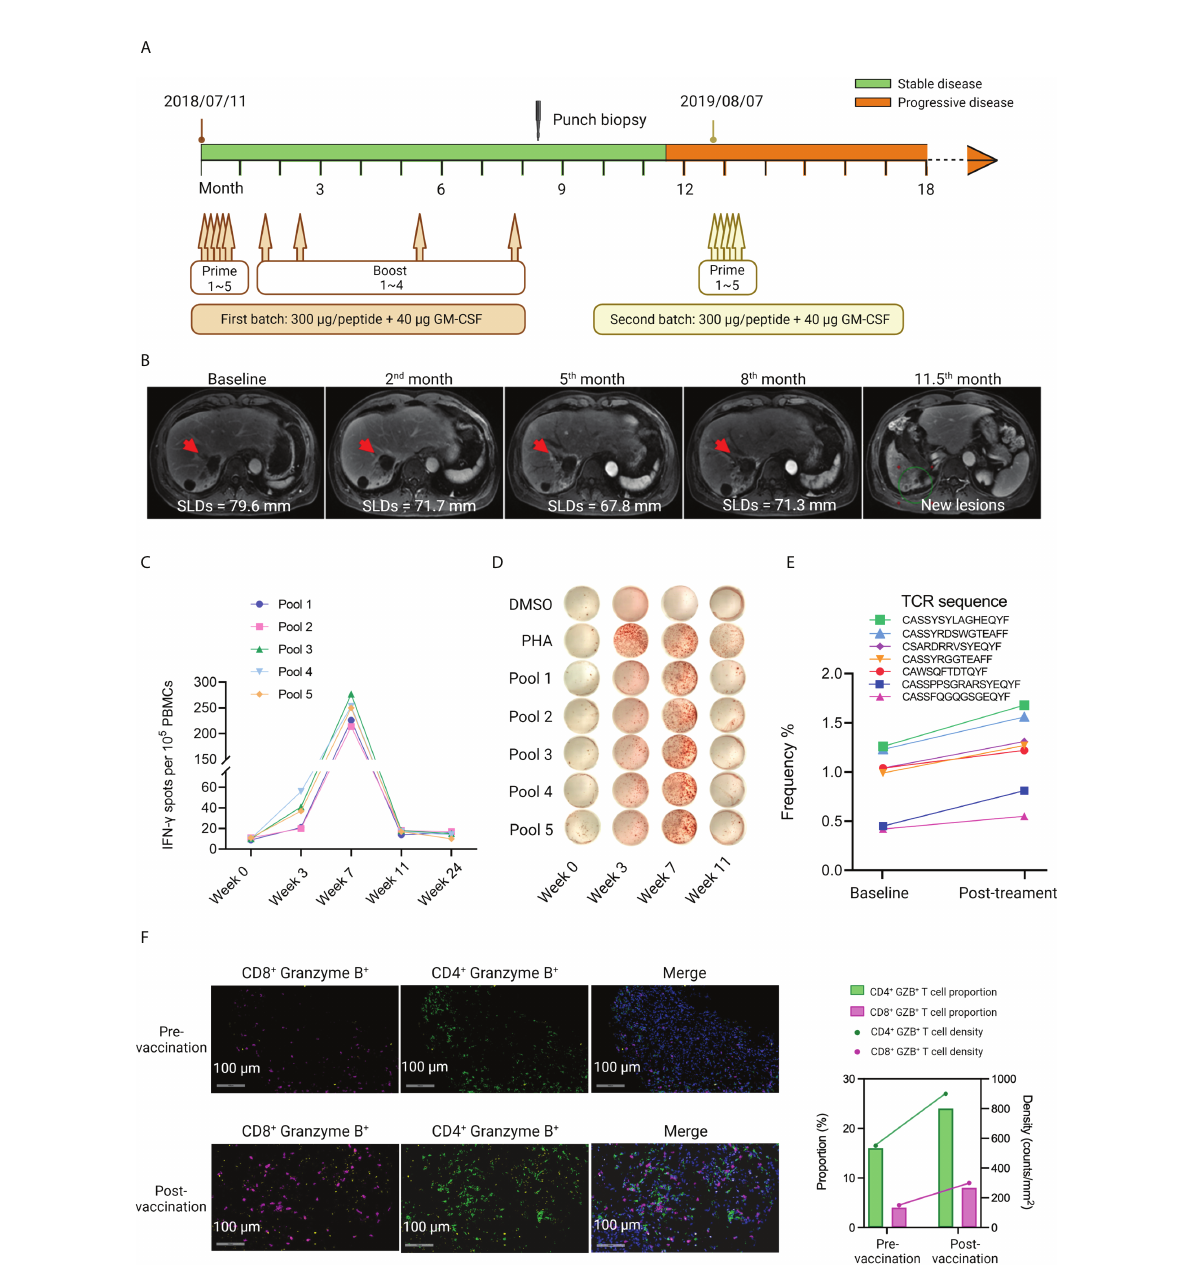
FIGURE 4 Case report of patient P015, who had multiple RFA treatments prior to vaccination. (A) The treatment scheme of patient P015. Two batches of iNeo-Vac-P01 were scheduled for this patient. (B) CT scan images of the tumor at different time points during the treatment. The red arrows indicated the corresponding tumor lesion. SLDs: sum of longest diameters. SLDs: sum of the longest diameters. (C, D) Ex vivo ELISpot assay of IFN- g + PBMCs during vaccination. (E) Increased abundance of peripheral neoantigen-speci fi c T cell clones post vaccination as detected by TCR sequencing. (F) Multiplexed IF images of FFPE samples obtained from patient P015 pre- and post-vaccination. Signals of CD8, CD4 and Granzyme B are shown in fuchsias, green and yellow. Double stranded DNA is shown in blue. Shown on the right are the proportion (%) and density (counts per mm 2 ) of CD4 + Granzyme B + and CD8 + Granzyme B +